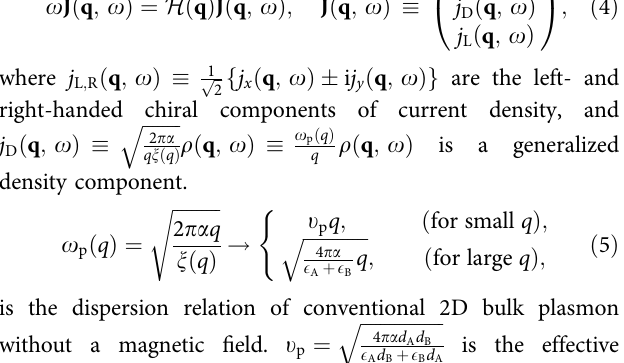
without a magnetic field. u p ¼